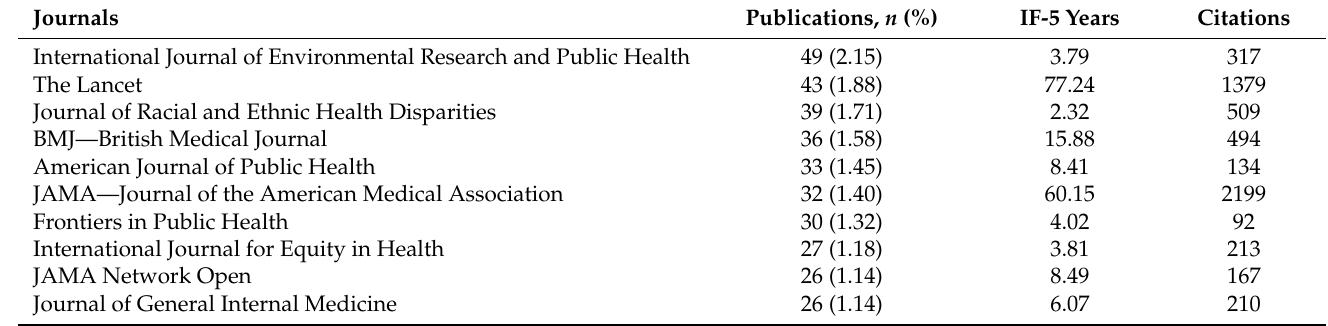
Table 4. Top 10 most productive journals for research on health disparity and COVID-19 ( n = 2282).